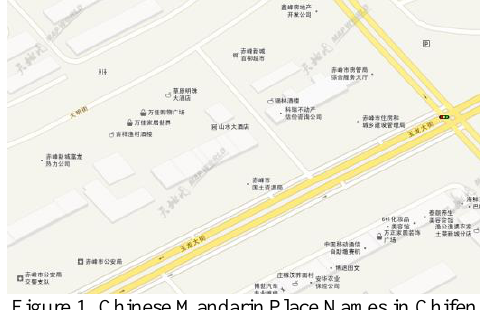
Figure 1. Chinese Mandarin Place Names in Chifen City, China